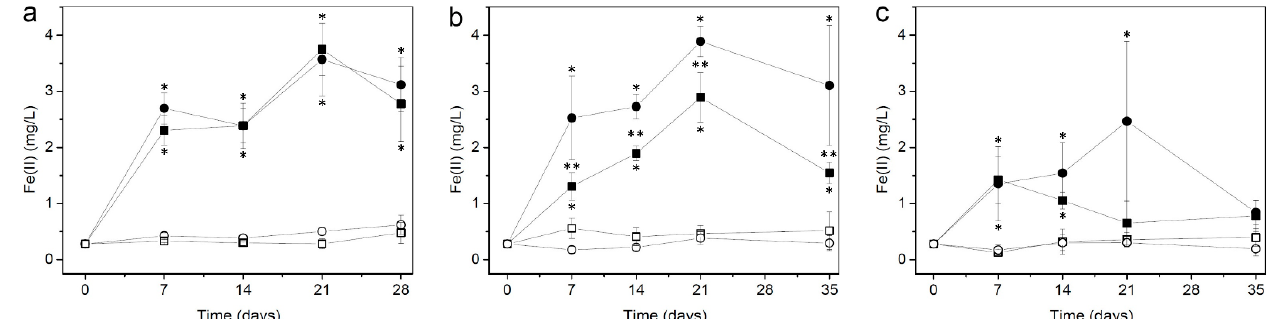
Figure 2. Fe(II) concentrations over time in the liquid phase of enrichment cultures. The iron sources for the cultures were either tailings (circles) or amorphous Fe(III) oxide (squares); closed symbols refer to the experimental, living enrichment cultures, and open symbols refer to control experiments using an autoclaved sediment as the inoculum. Bars show the standard deviation. Asterisks indicate statistical significance between experimental and control cultures (*) or between the two Fe(III) sources (**) (Student’s t -test, p < 0.01). Inocula were obtained from ( a ) the Doce River in the Governador Valadares Municipality (DR-GV), affected by tailings; ( b ) the Gualaxo do Norte River in the Barra Longa Municipality (GNR-BL), highly affected by tailings; and ( c ) the Gualaxo do Norte River in the Mariana Municipality (GNR-M), not affected by tailings from the Fundão Dam.